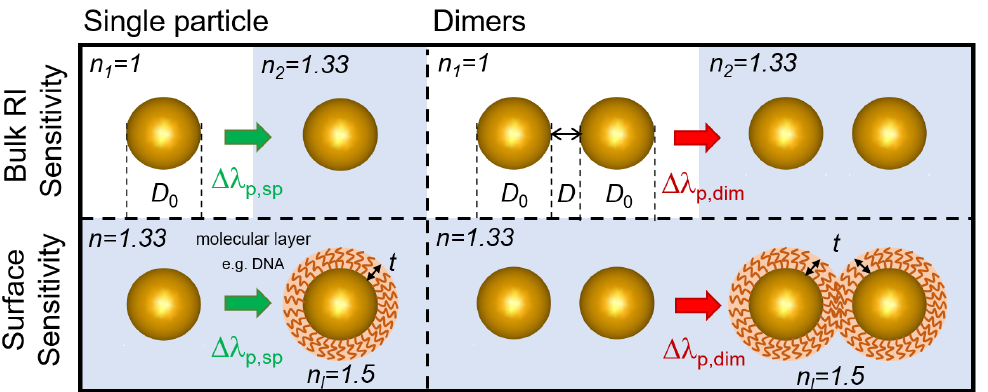
Figure 1. Illustration of the different simulation conditions and the definitions of bulk RI sensitivity (RIS) and surface sensitivity. Symbols: D 0 —nanosphere diameter, D —interparticle distance (gap), ∆ λ p —extinction peak shift (for single particles, sp, and dimers, dim), t —dielectric layer thickness, n l —dielectric layer refractive index.